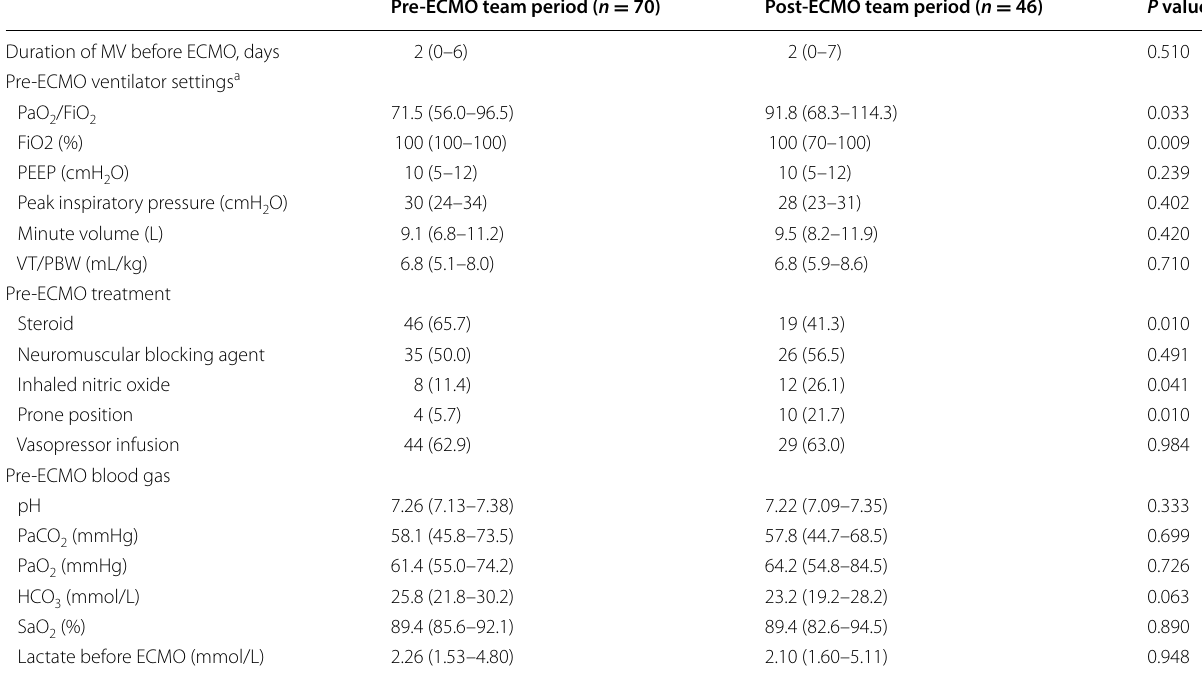
Values are given as the median (interquartile range) or n (%) ECMO extracorporeal membrane oxygenation, FiO 2 fraction of inspired oxygen, MV mechanical ventilation, PaCO 2 partial pressure of carbon dioxide in arterial blood, PaO Data were available for 104 patients (66 patients in the pre-ECMO team period and 40 patients in the post-ECMO team